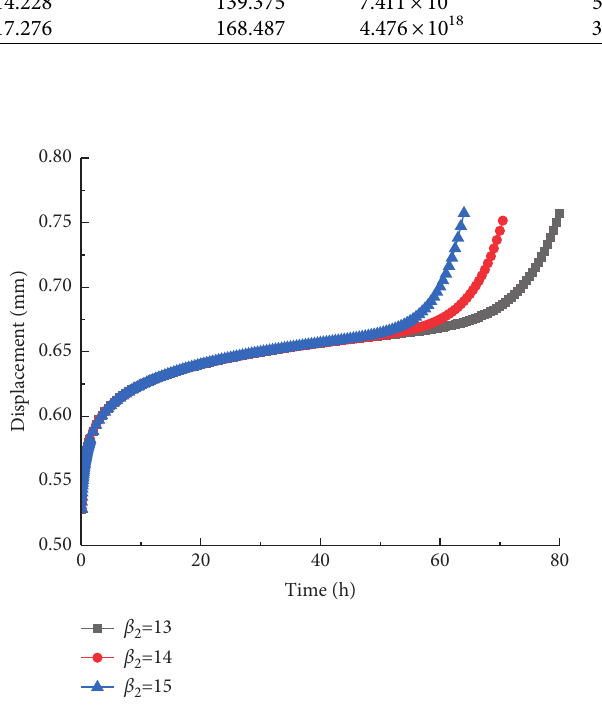
Figure 7: Creep curves under different fractional orders. Figure 8: Creep curves under different viscoelastic